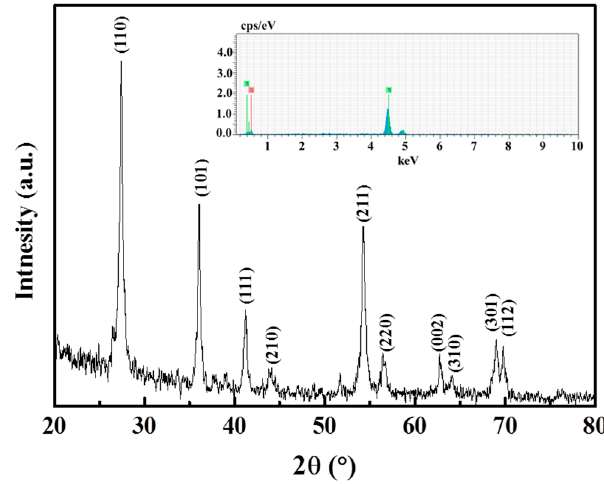
Figure 3. XRD pattern of synthesized TiO 2 nano-flowers.